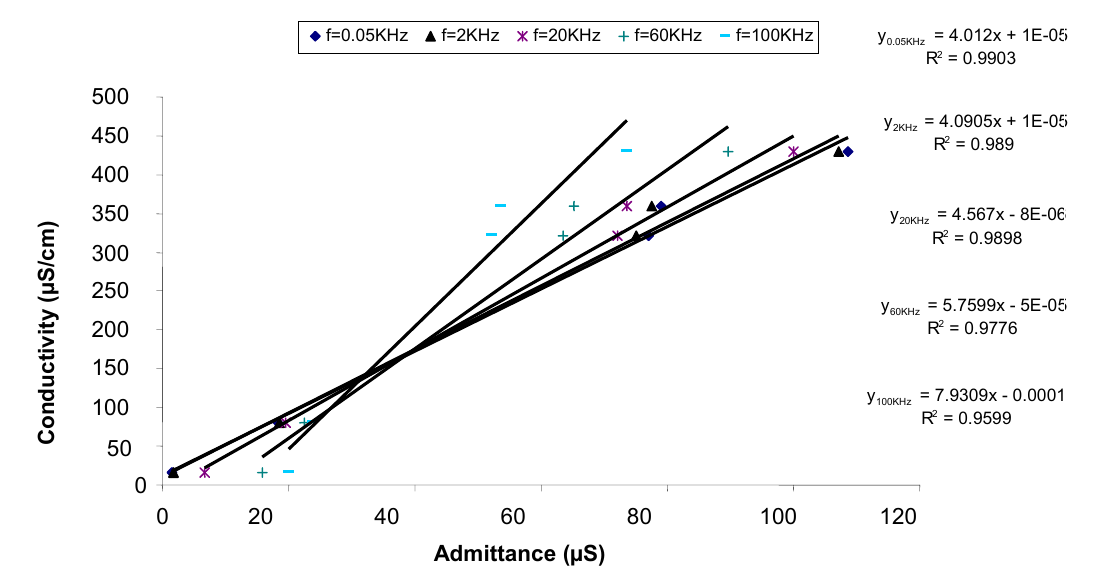
Figure (4): The linear relationship between admittance and conductivity at frequencies (0.05, 2, 20, 60 and 100 kHz) for the 2-outer electrode system.